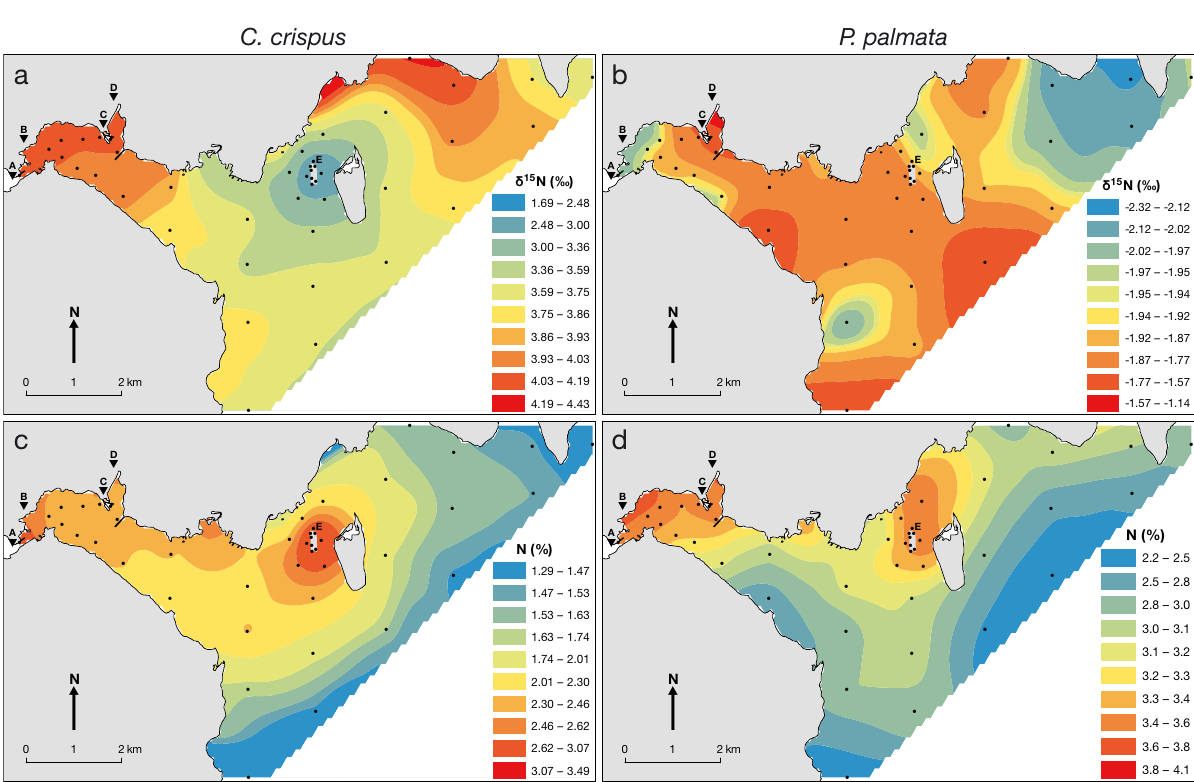
Fig. 3. (a,b) δ 15 N and (c,d) total N content of the macroalgae Chondrus crispus (a,c) and Palmaria palmata (b,d). Points represent deployment stations. Triangles indicate probable point sources (labelled as in Fig. 2)